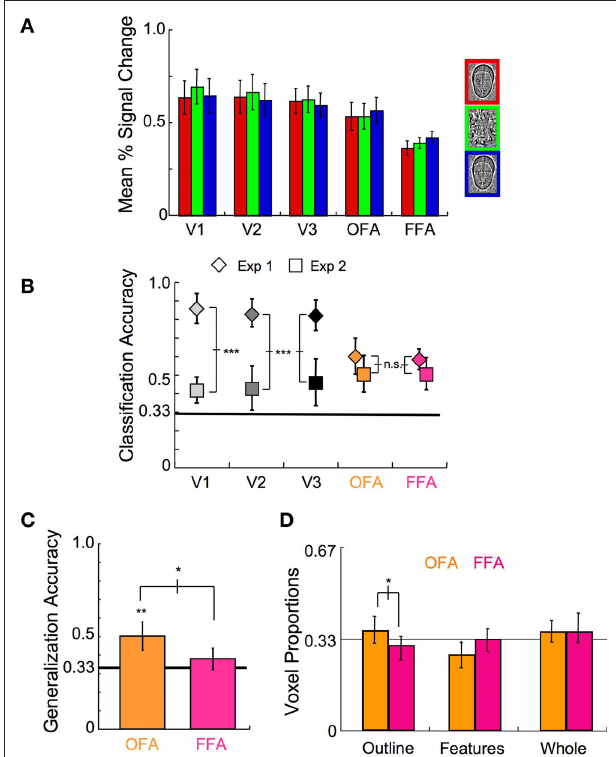
Figure 9 | experiment 2 results. (A) The mean response level to the different scrambled stimulus categories (21 samples each; error bars, 1 s.e.). (B) Results of the multi-class SVM analysis within early visual areas and face-selective cortex for Experiment 1 ( ◊ ) and Experiment 2 (  ) (error bars, 95% c.i.). (C) Categorization accuracy of classifiers trained to discriminate fMRI responses to scrambled stimuli that were then tested on independent fMRI responses to unscrambled stimuli (error bars, 95% c.i.). (D) The relative proportion of voxels that maximally contributed to the three stimulus categories within the OFA and the FFA (error bars, 95% c.i.). Asterisks indicate the level of significance for paired t -tests in (B–D) and independent t -tests relative to chance in (C) (* p < 0.05, ** p < 0.01, *** p <